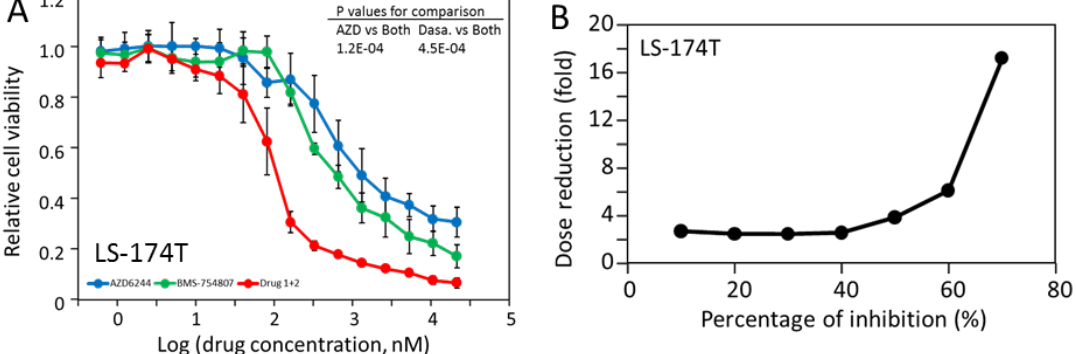
Figure 6. Drug sensitivity of LS-174T. ( A ) The viability of LS-174T in response to treatment by AZD-6244, dasatinib and their combination. The P values for the comparisons between the drug combination and each individual drug are shown on the upper right couner. ( B ) The dose reduction index for the AZD-6244 and dasatinib combination as a function of percentage inhibition.